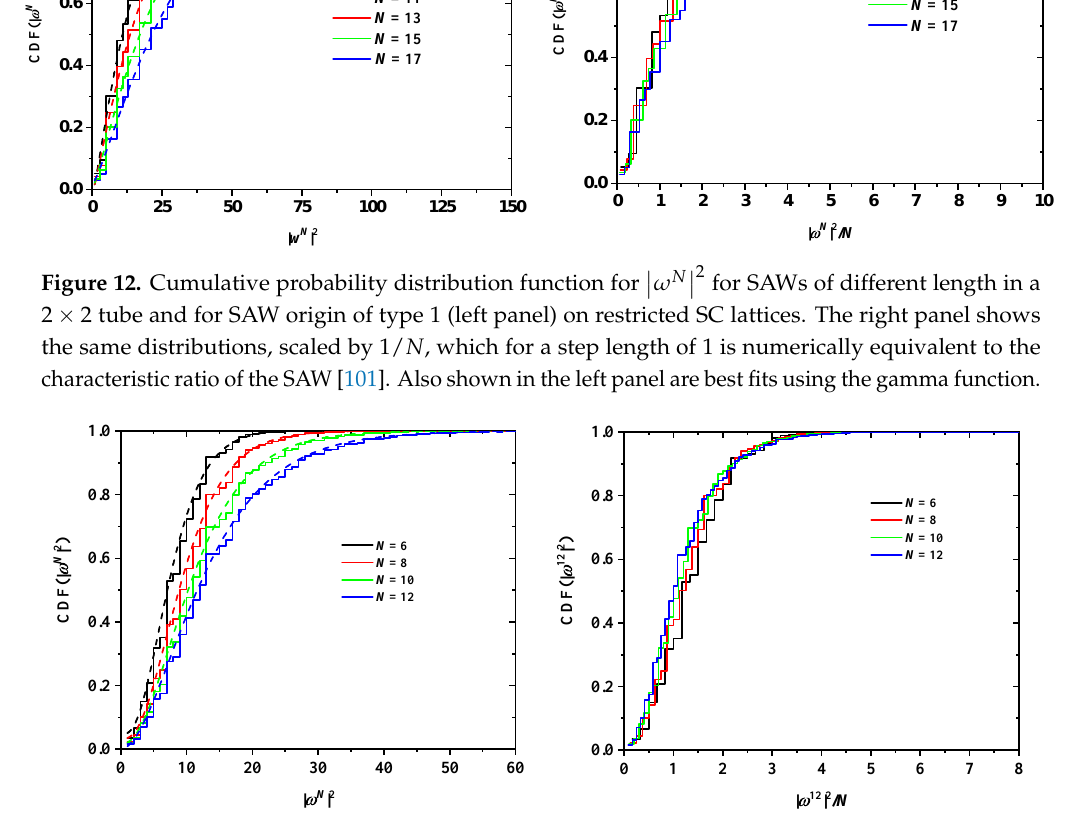
(cid:12) (cid:12) 2 for SAWs of different length in a (cid:12) ω N (cid:12)